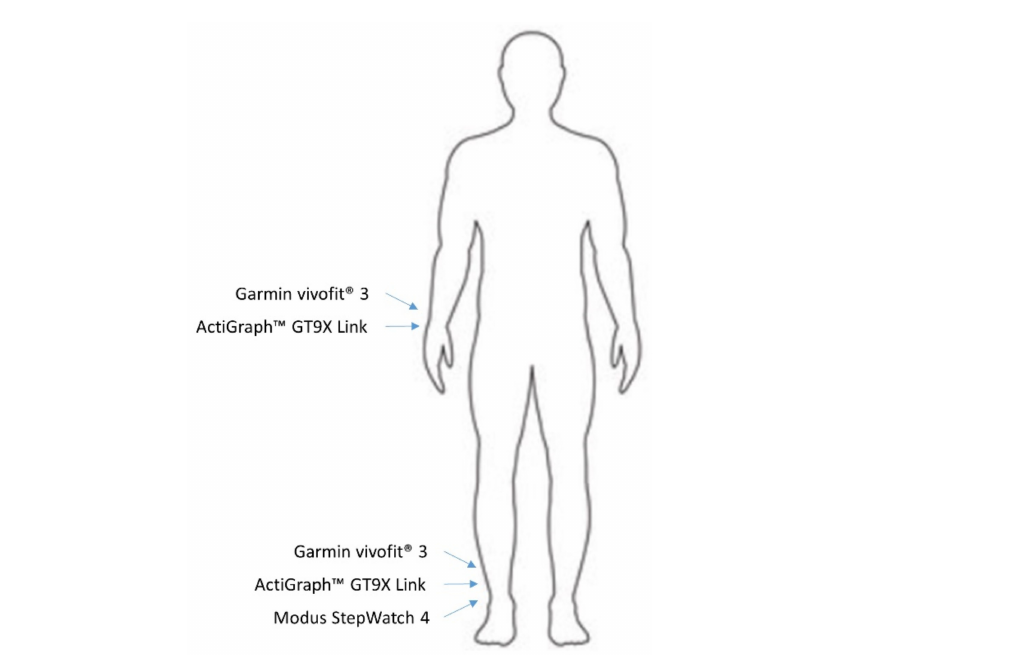
Figure 1. Placement of the activity monitors at the non-dominant wrist and prosthetic